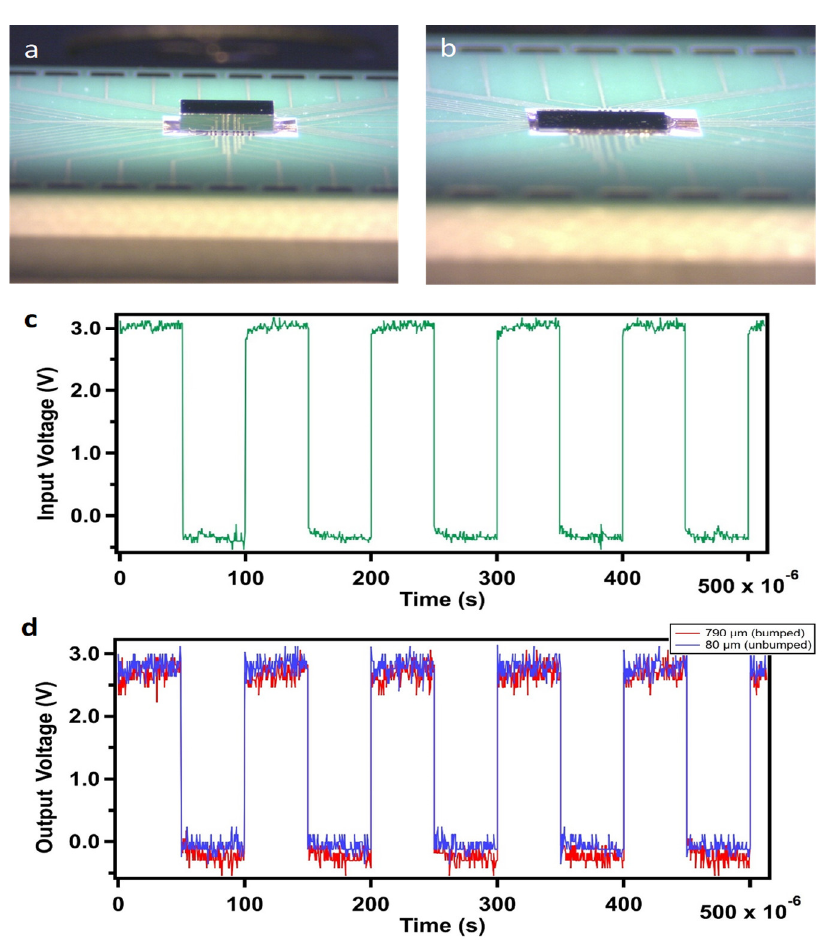
Figure 10. Die-level thinning of CMOS chips; a comparison between flip-chip bonded CMOS chips from MPW: ( a ) the original chips (with a thickness of 790 µm) and ( b ) die-level thinned chip (with a thickness of 80 µm ± 2 µm), ( c ) the input signal (green) and, ( d ) output of the CMOS chips, (790 µm in Red) and (80 µm in blue).